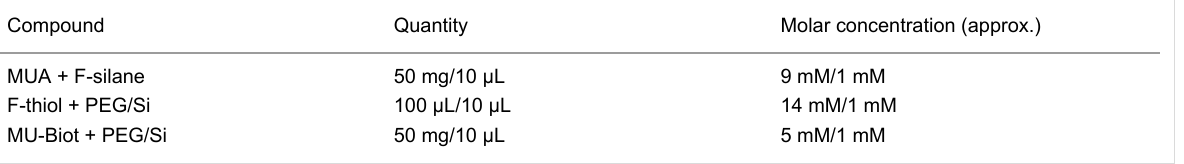
Table 1: Thiol/silane mixtures used for orthogonal functionalization in 25 mL of DCM. Compound Quantity Molar concentration (approx.) 50 mg/10 µL 9 mM/1